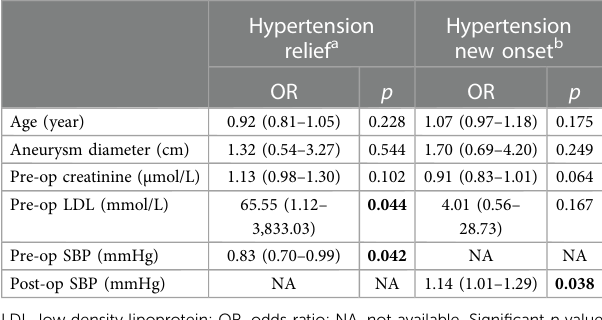
TABLE 3 Predictors for hypertension relief after operation and new onset at